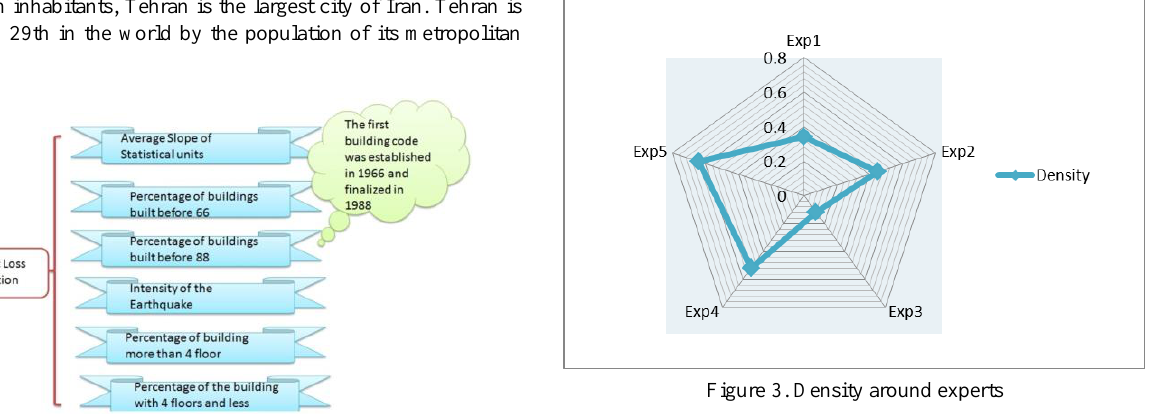
Figure 2. Contributing criteria